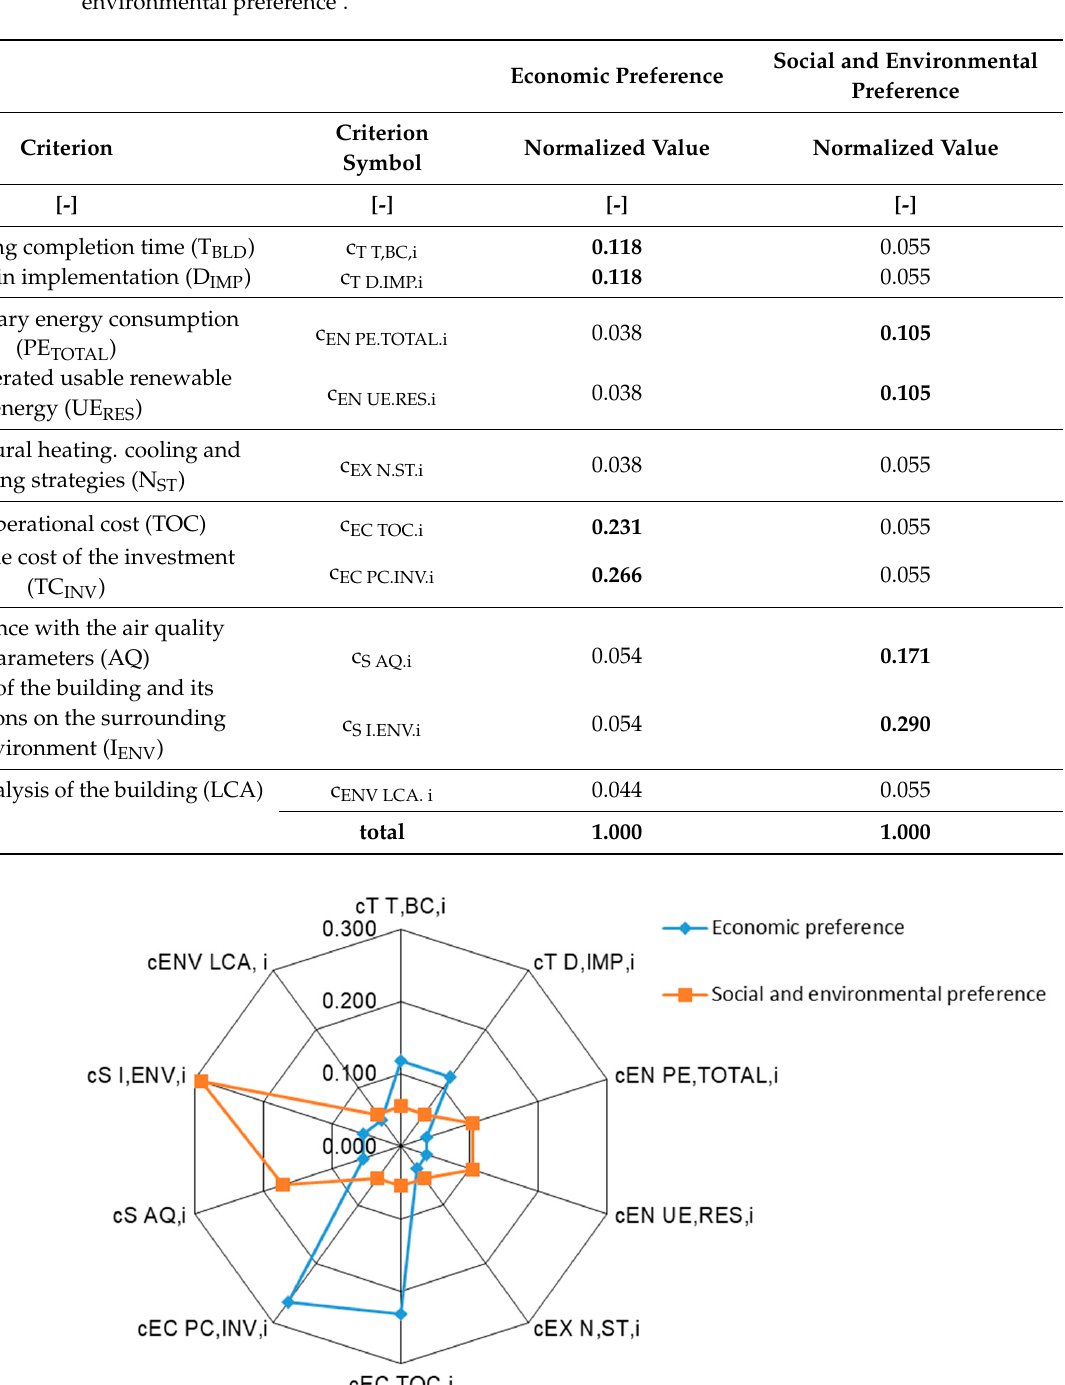
Table 4. Weight vectors for the selected evaluation criteria: ‘Economic preference’ and ‘social and environmental preference’.